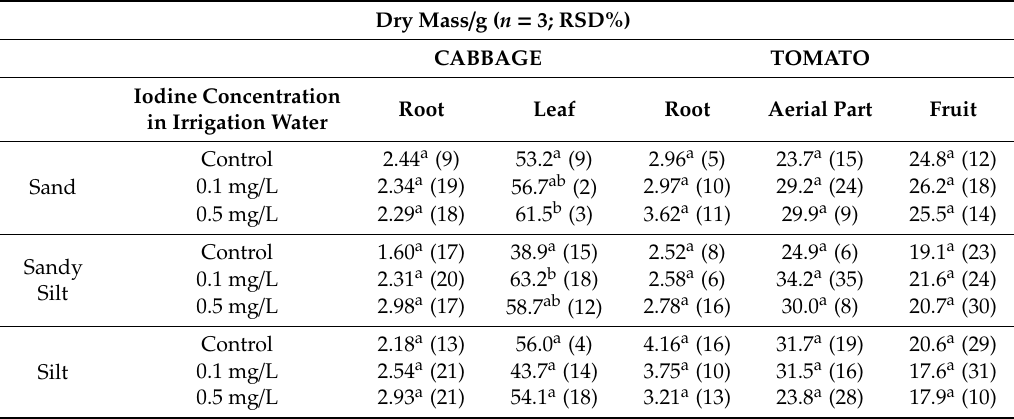
Table 3. E ff ect of iodine concentrations in the irrigation water on dry mass of the investigated plants. Values indicate means of three replicates (RSD%), while di ff erent letters indicate statistically significant di ff erences between the treatments ( p < 0.05, linear regression, Tukey’s